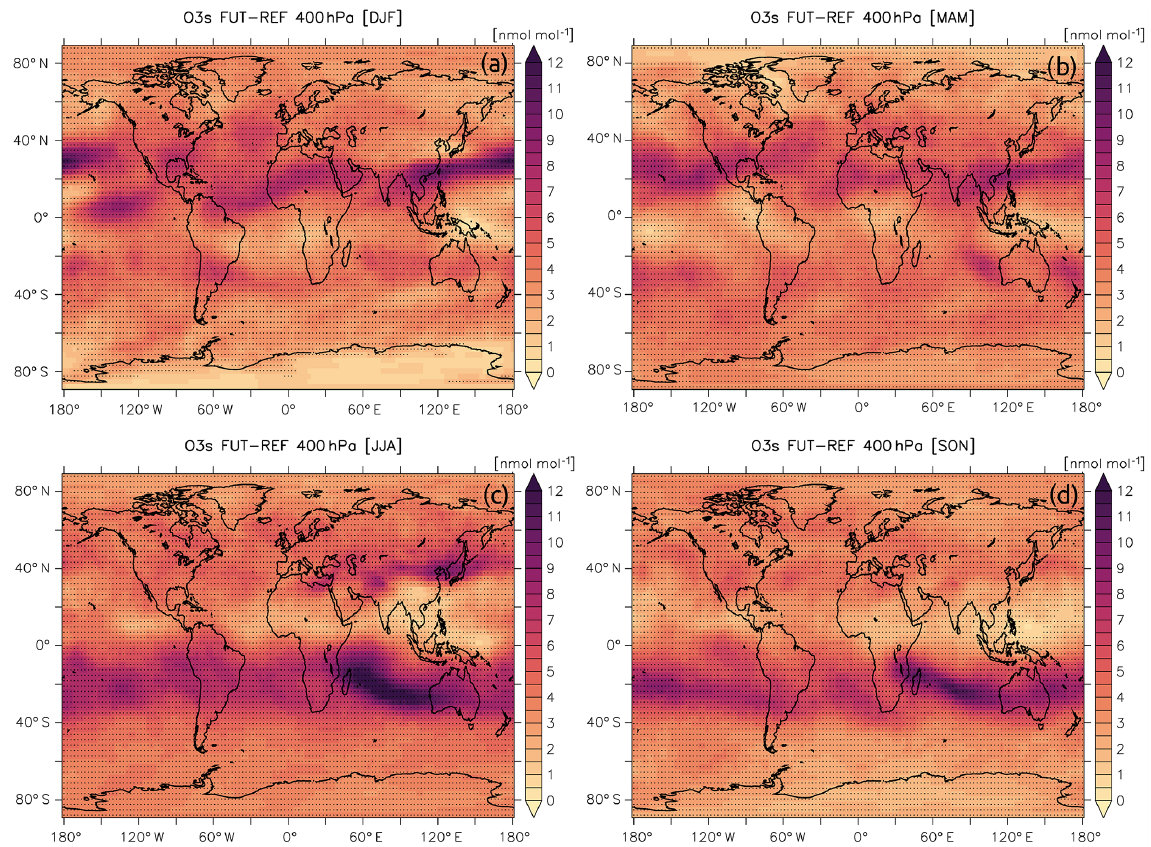
Figure 7. Mean stratospheric ozone tracer (O 3 s) concentration differences (shaded; nmolmol − 1 ) between the FUT and REF periods at 400hPa for DJF (a) , MAM (b) , JJA (c) , and SON (d) . Black dots denote statistically significant differences at the 99% significance